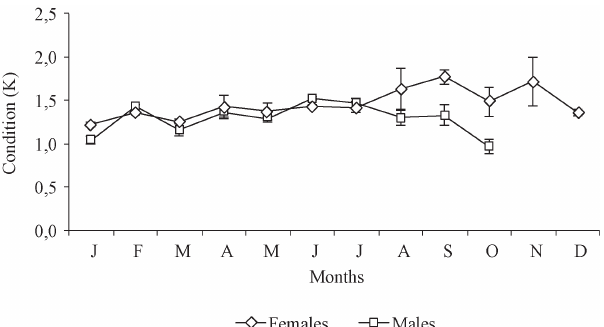
Fig. 7. Seasonal variation of the condition index (K) of P. sphenops in the Emiliano Zapata